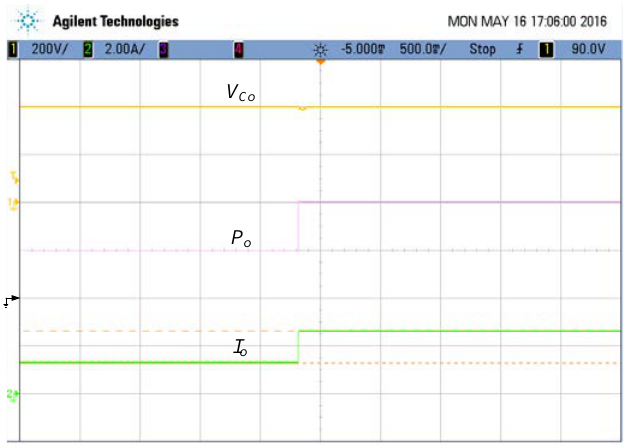
Figure 10. Measured waveforms of active switches at the PV input port while the output power is 1 kW ( v sw,wind : 10 V/div, v sw,pv : 10 V/div, v ds,pv : 50 V/div, i ds,pv : 20 A/div, time: 5 μs/div).